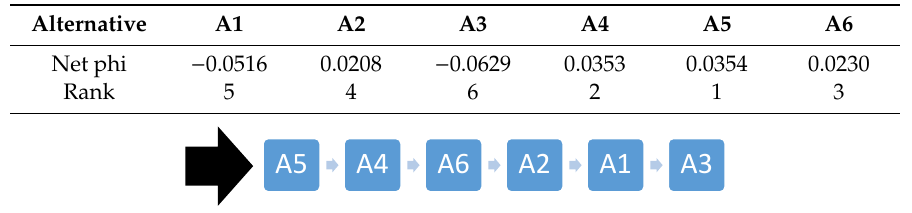
Table 16. Change 1 results.